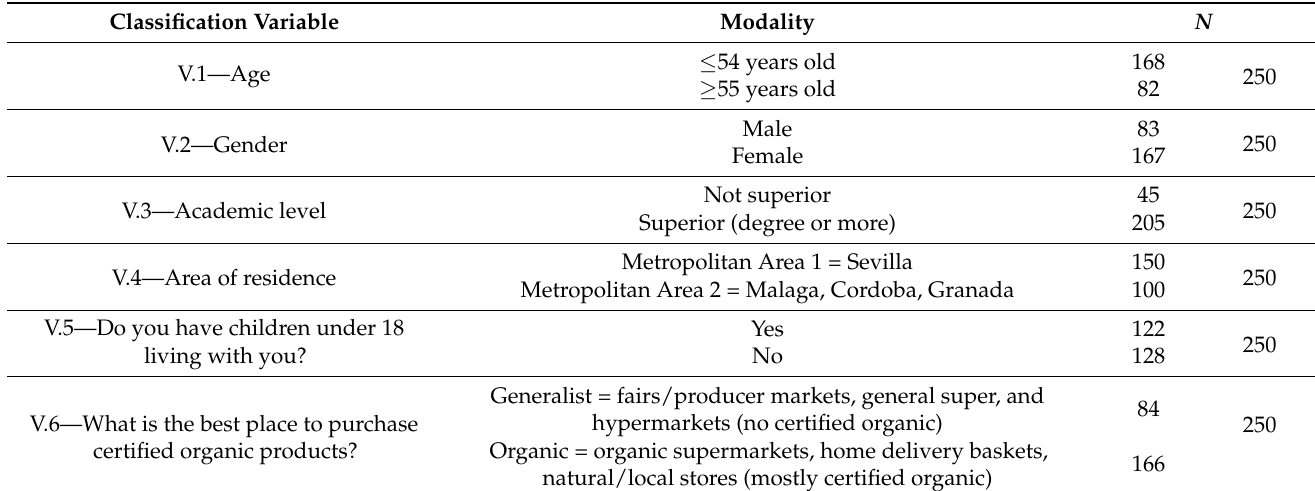
Table 3. Modified sample structure.